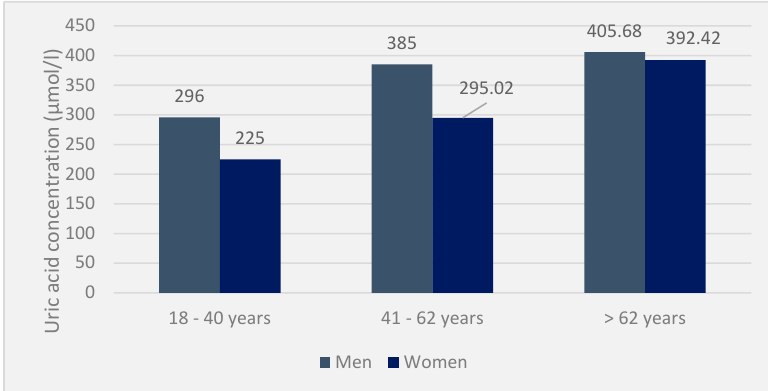
Figure 1. Uricemia in the general population by age and sex ( n = 85).